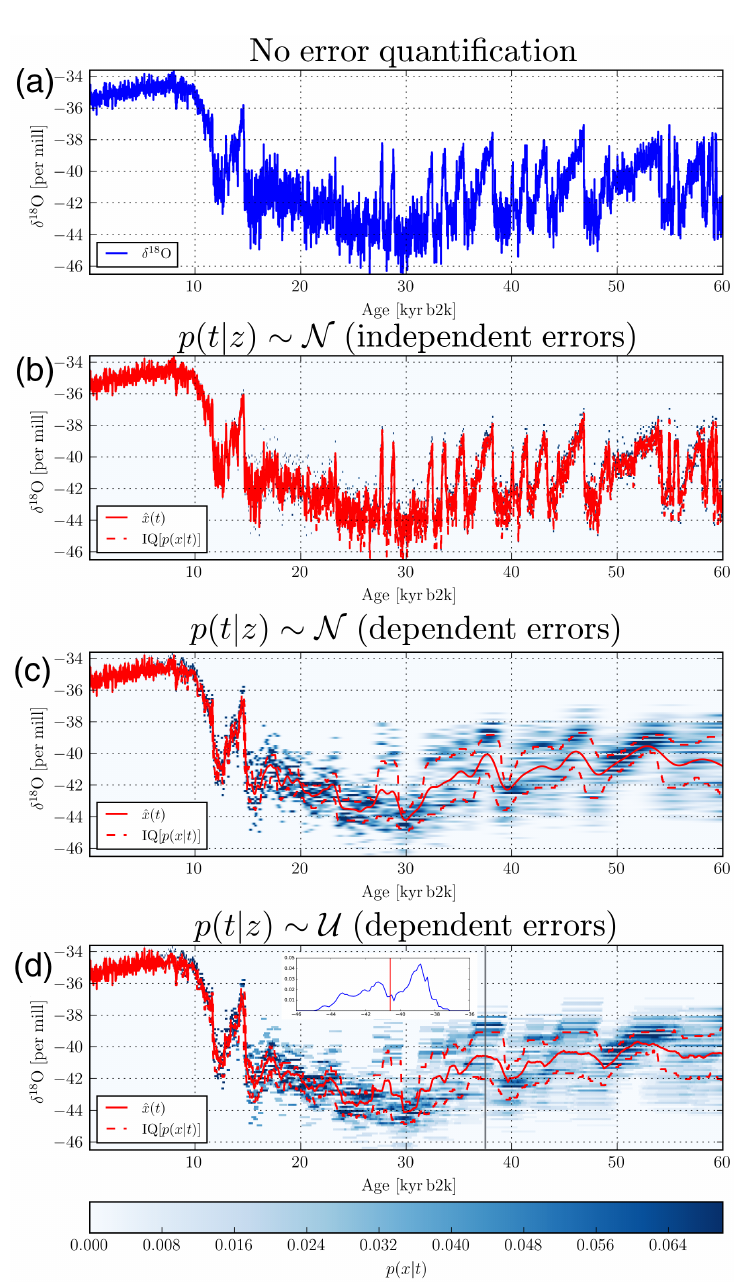
Figure 3. Representation of the NGRIP δ 18 O record, taking into account absolute counting errors in the dating. (a) Traditional representation of the record with no accounting for dating uncertainties at all: the time steps are obtained as the mean values of the corresponding dating uncertainty distributions. (b) Representation of the same dataset as a sequence of probability densities, derived via Eq. (4); here we used a normal distribution with σ = (cid:0) 2 · MCE (cid:1) 1 / 2 / 2, which corresponds to uncorrelated errors, for the age uncertainty distribution p ( t | z ). The blue shading showing the distributions p ( x | t ) as a function of the prescribed time t is, due to the small σ for uncorrelated errors, only visible as single blue points. In this case, the time-dependent expectation value of x = δ 18 O with respect to p ( x | t ), denoted by ˆ x ( t ) (red), closely resembles the traditional representation in panel (a) . (c) Same as panel (b) , but using a normal distribution with σ = MCE / 2 to represent the counting errors. (d) Same as (b) , but using a uniform distribution of width 2 · MCE to represent the counting errors. The inset shows p ( x | t ) (blue) and ˆ x ( t ) (red) at t = 37 . 5kyrb2k, also indicated by the grey vertical line in the main panel. Note that, in panels (c, d) , the spread of the distributions p ( x | t ) – as quantified by the interquartile (IQ) range of p ( x | t ) (dashed red line) – becomes wider the further one goes into the past. This increase in the spread of p ( x | t ) is also reflected by a decrease in the high-frequency variability of its expectation values ˆ x ( t